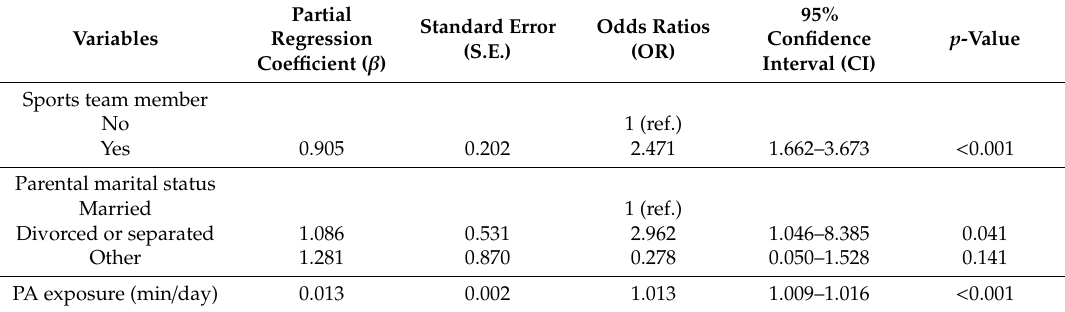
Table 5. Multivariate logistic regression to estimate risks factors for physical activity-related injuries (PARI) among